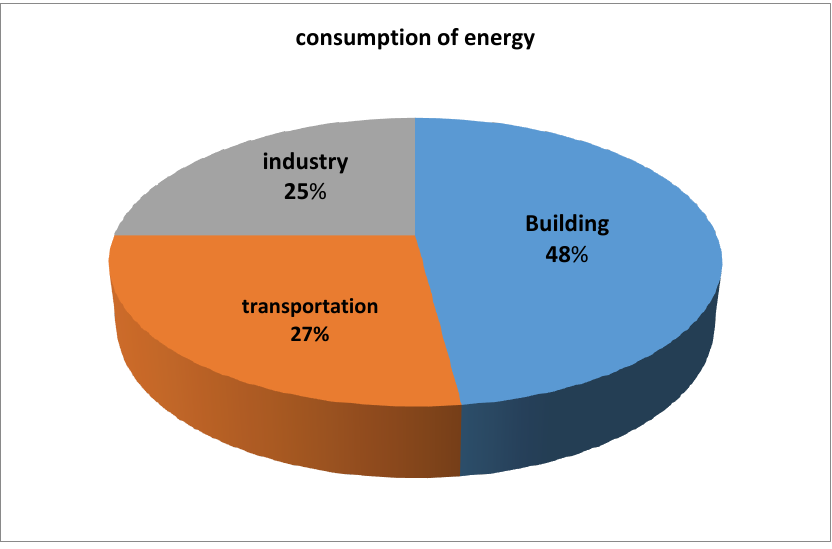
Figure 1. consumption of energy-(UNEP,